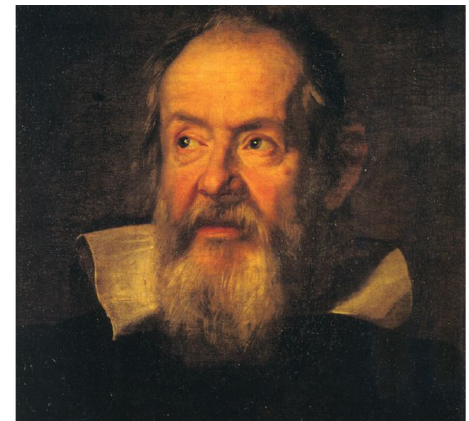
Figure 3: One of Sustermans’ portaits of